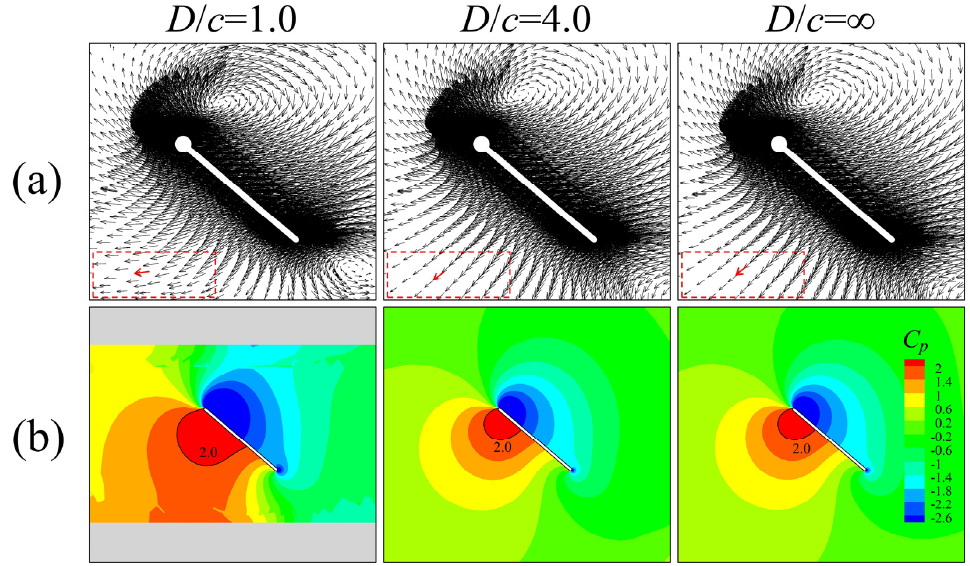
Figure 11. ( a ) The velocity vectors; ( b ) the pressure contours on the slice at 2/3 of wingspan in the middle of the first downstroke ( τ = 0.25 ) for 𝐷 𝑐⁄ = 1.0, 4.0 and ∞ at 𝑅𝑒 = 10 .